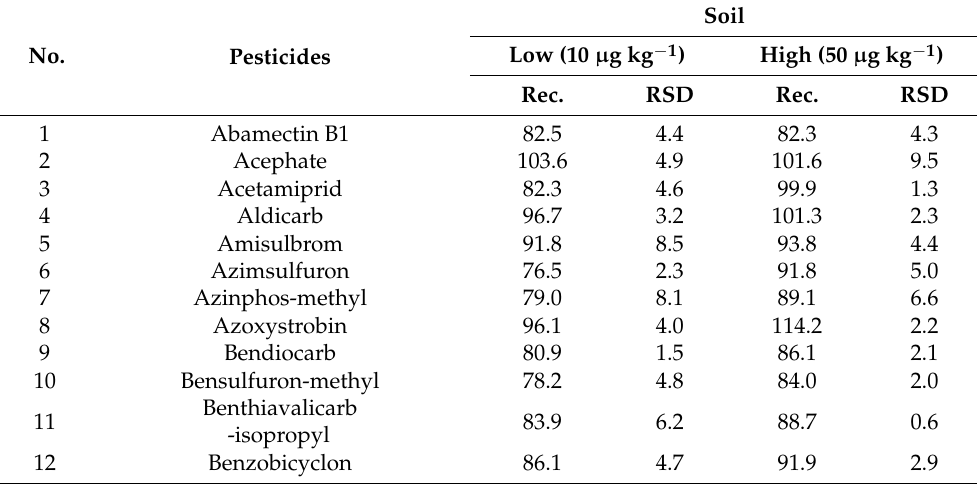
Table 6. Recoveries of 40 pesticides in the untreated soil using LC–MS/MS ( n = 3). Recoveries for the other 179 pesticides are listed in Table